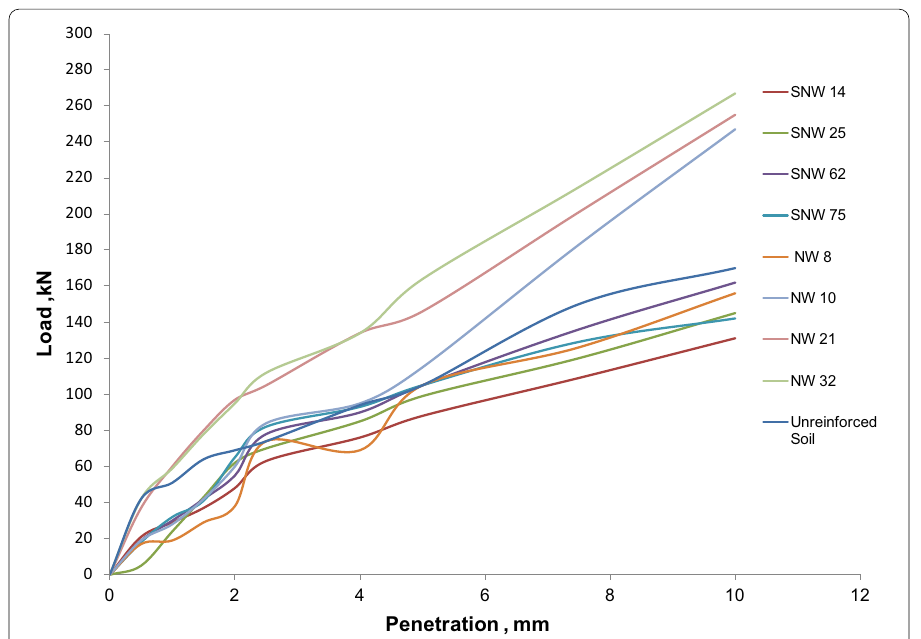
Fig. 8 Load-penetration response of the NW, SNW and unreinforced